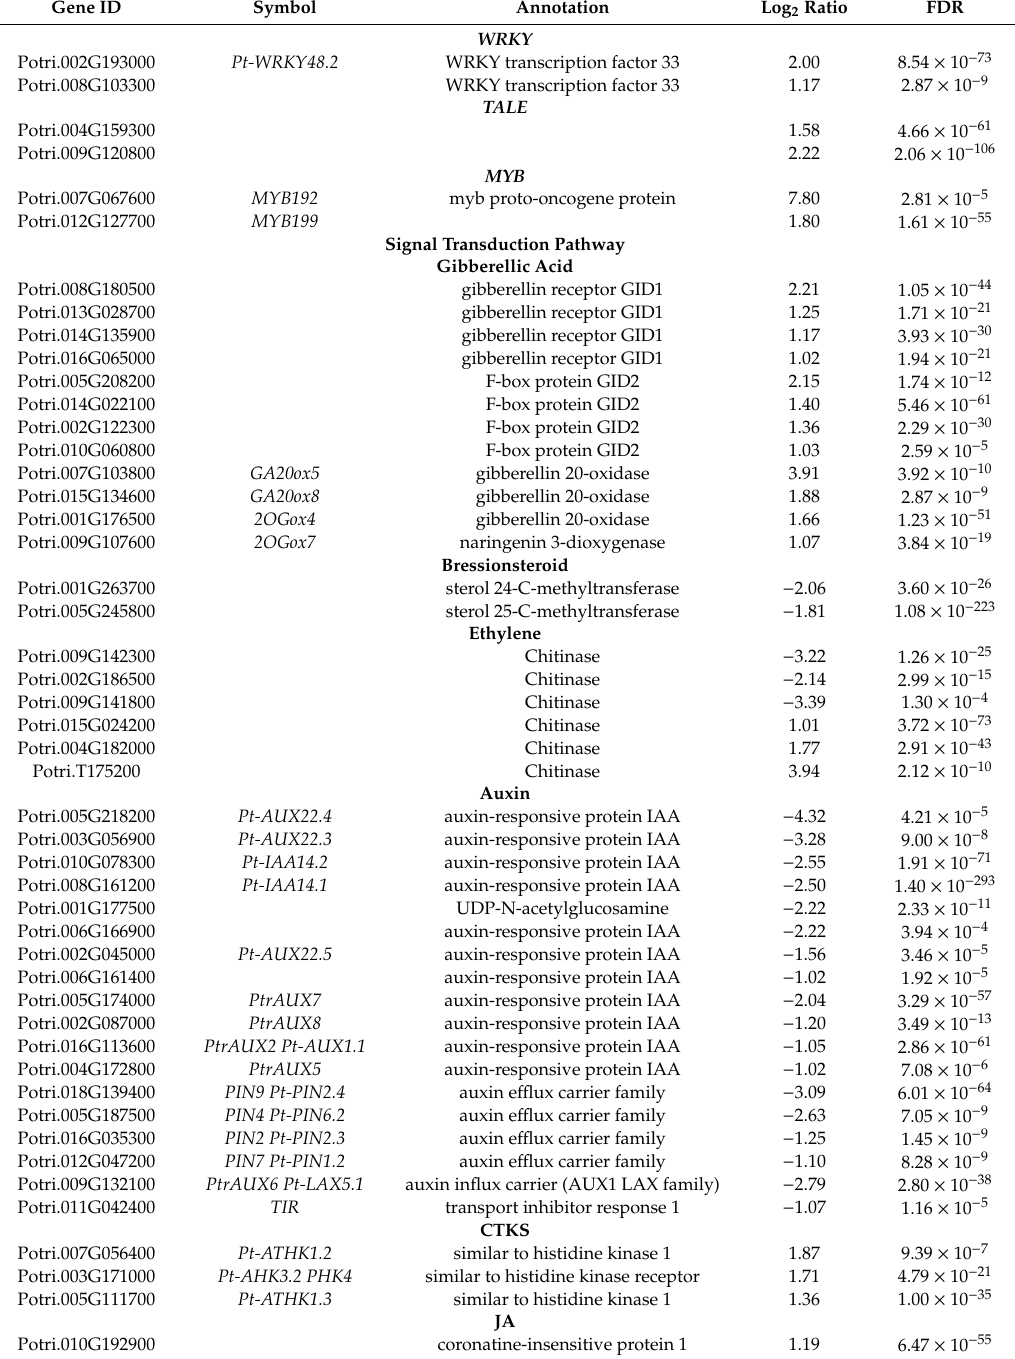
Table 3. Significantly di ff erentially expressed transcription factors and phytohormone related genes in roots of ‘Nanlin895’ exposed to boron